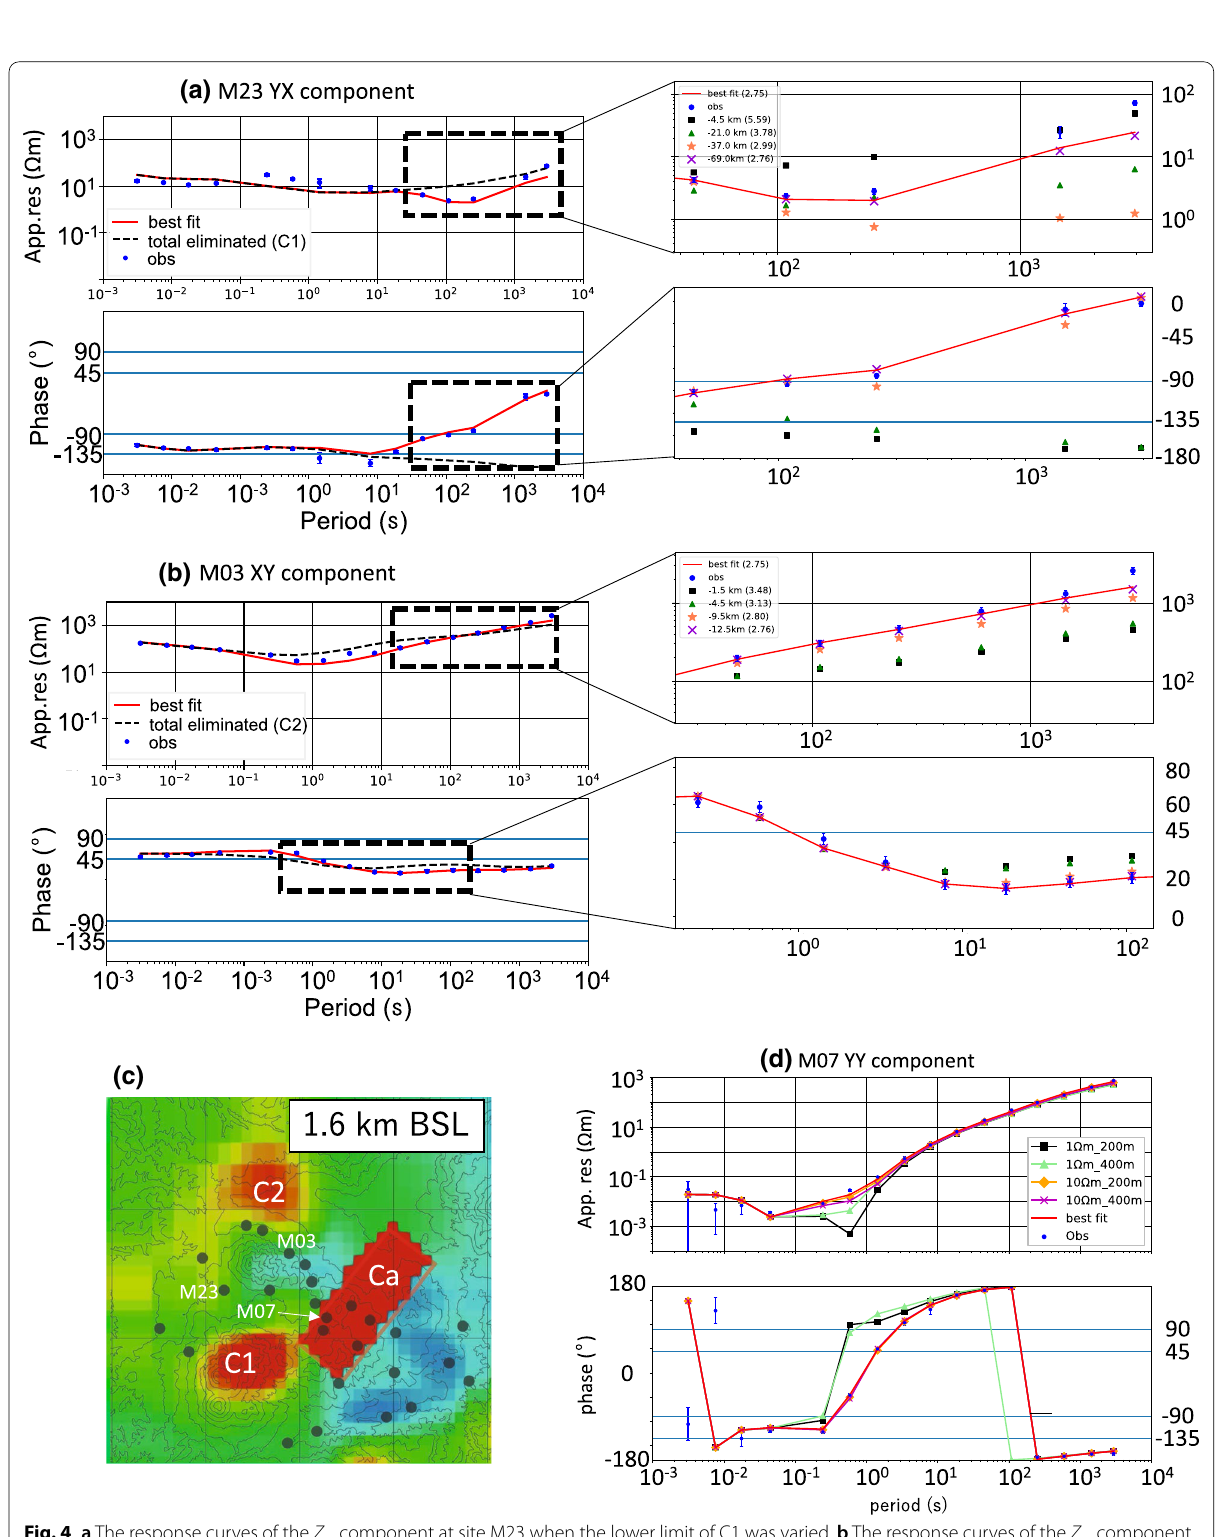
Fig. 4 a The response curves of the Z yx component at site M23 when the lower limit of C1 was varied. b The response curves of the Z xy component at site M03 when the lower limit of C2 was varied. Each symbol in the a and b represents the model response when D max is varied. The values in parentheses are the RMS misfit values for the model. c The model with a thin conductive brick (Ca) corresponding to the sill-like pressure source (top depth at 1.5 km). d The response curves of the Z yy component at site M07 when the bulk resistivity value and the thickness of Ca were